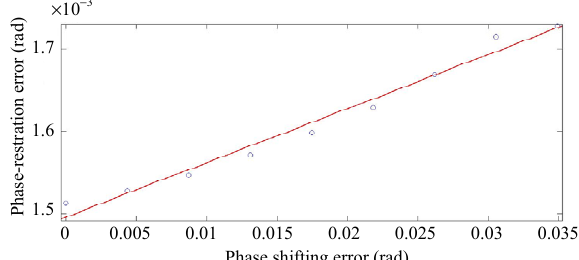
Fig. 6 Relationship between the phase-restoration error and phase shifting error.